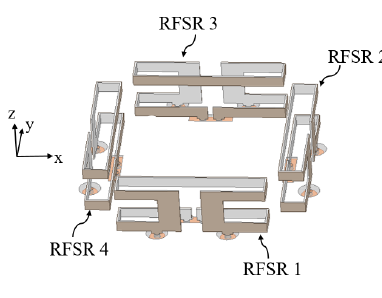
Figure 1: Configurations of the proposed MIMO antenna cell.